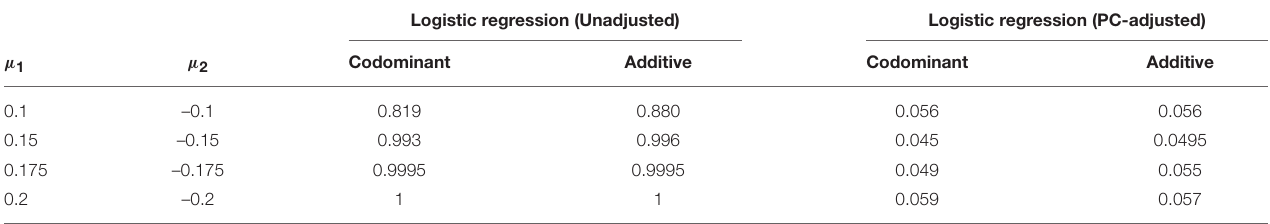
TABLE 4 | Estimated false positive rates before and after adjustment using the top five principal components. Logistic regression (Unadjusted) Logistic regression (PC-adjusted)